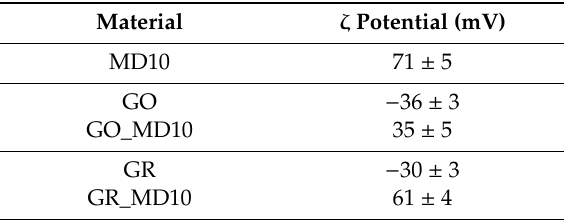
Table 2. ζ potentials of the different materials.